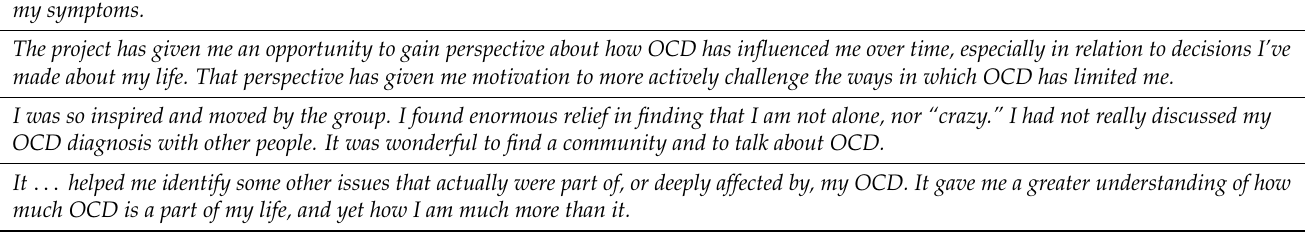
Table 3. Participant open-ended survey